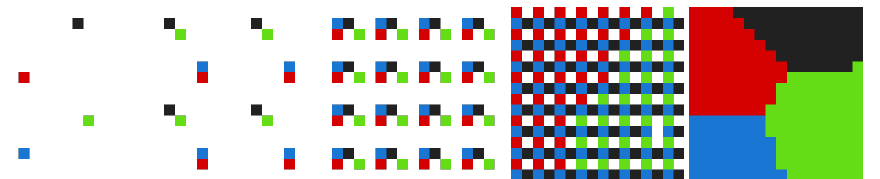
Figure 1. From ( left ) to ( right ): consecutive steps of Jump Flooding algorithm for image of resolution 16 × 16